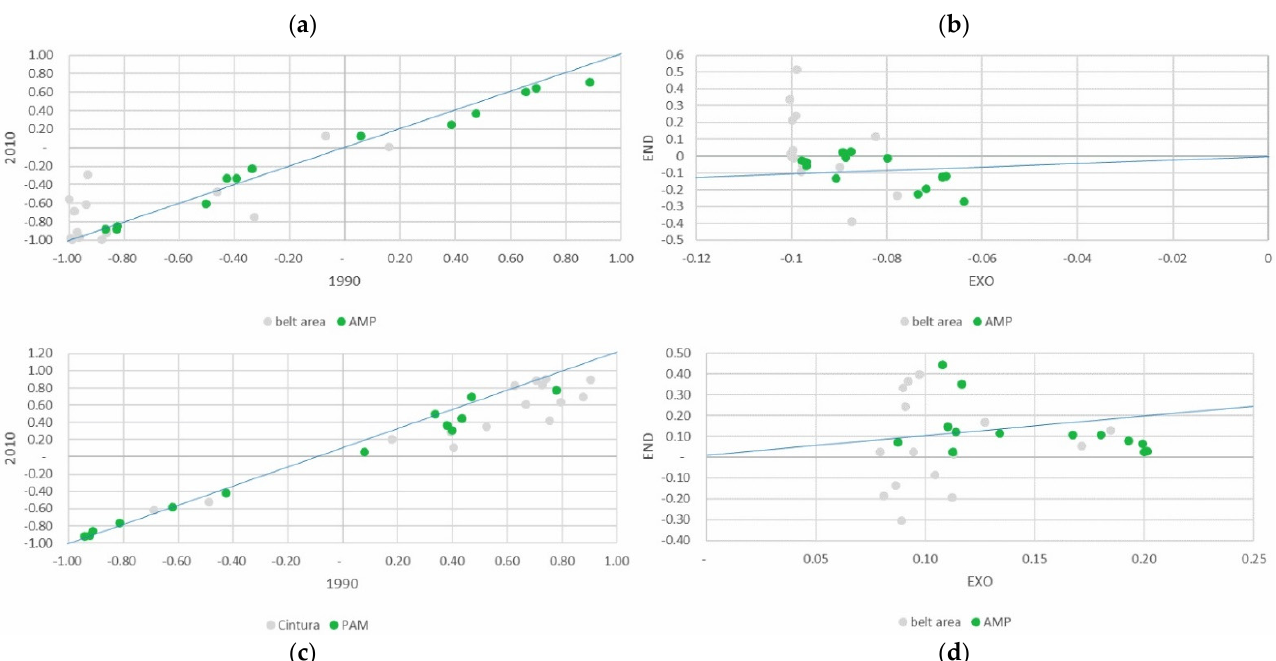
Figure 18. ( a , b ) PSI and DPSI of family vegetable gardens. Source: Drawn up by the authors using data provided by the ISTAT.